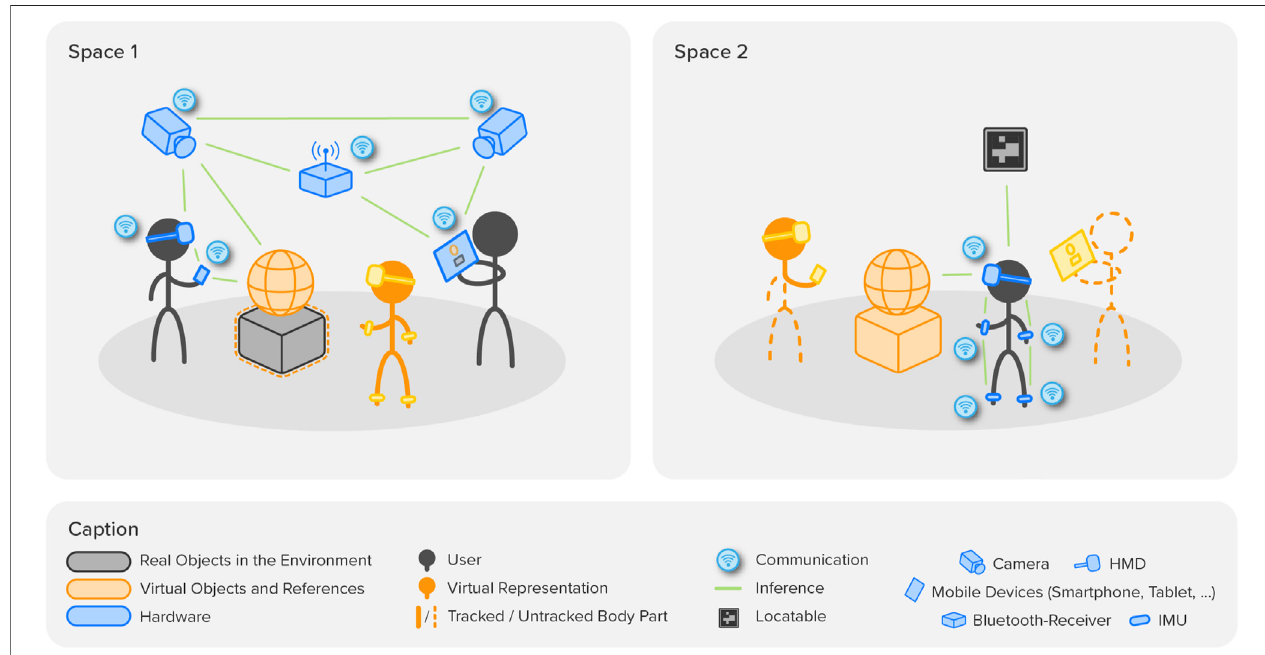
FIGURE 1 | Example Scenario: Tele-collaborative MR-application across two shared environments. Objects and users have real and/or virtual representations on either end. A multitude of devices is used to interface with the shared environment.